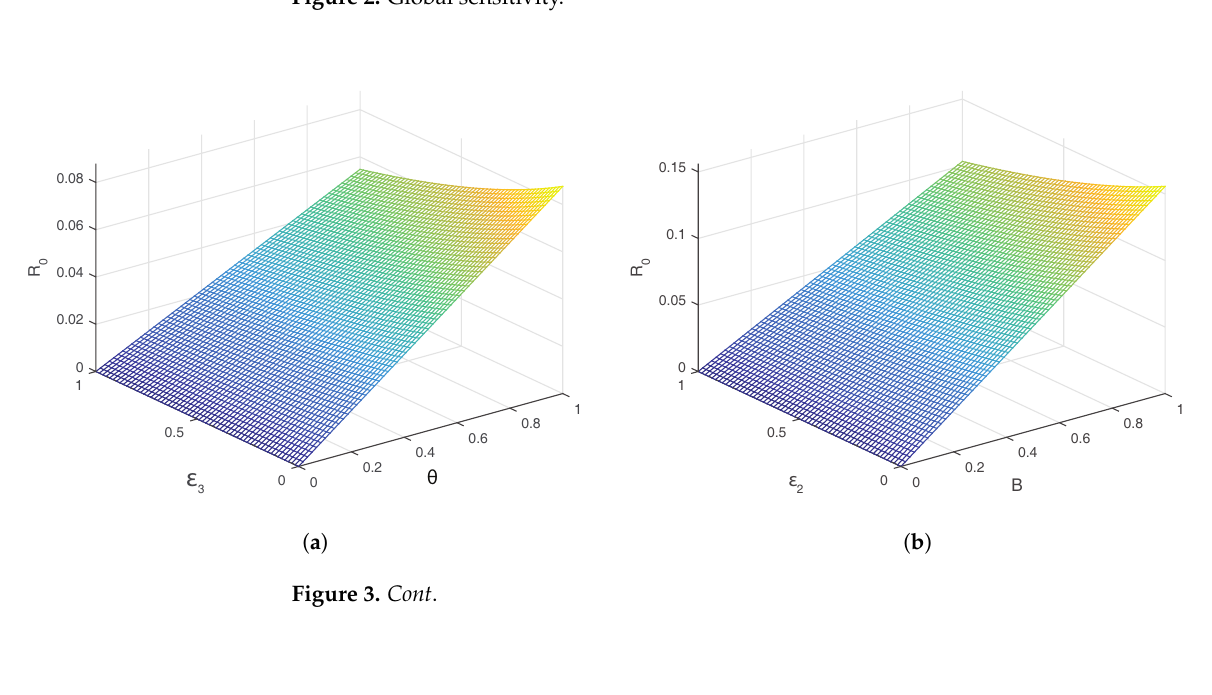
Figure 2. Global sensitivity.